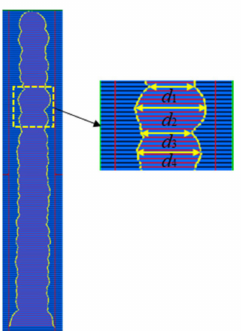
where S b indicates the surface roughness along sample height or width direction, D i indicates the maximum height or width value of each section, and n indicates the sec- tion